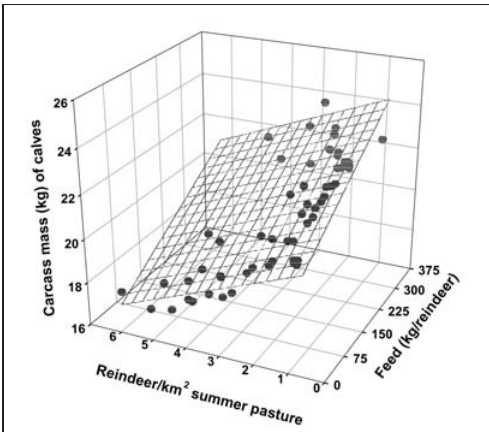
Fig. 4. Dependence of the average meat production per reindeer in the period 1993-99 on reindeer den- sity on summer pastures and feeding of reindeer in the Finnish reindeer management area ( R 2 =0.368, y = -0.696x + 0.019z + 12.956, where y = meat production, kg/reindeer; x = reindeer/km 2 summer pasture; z = feed, kg/rein- deer n =56, P <0.001).